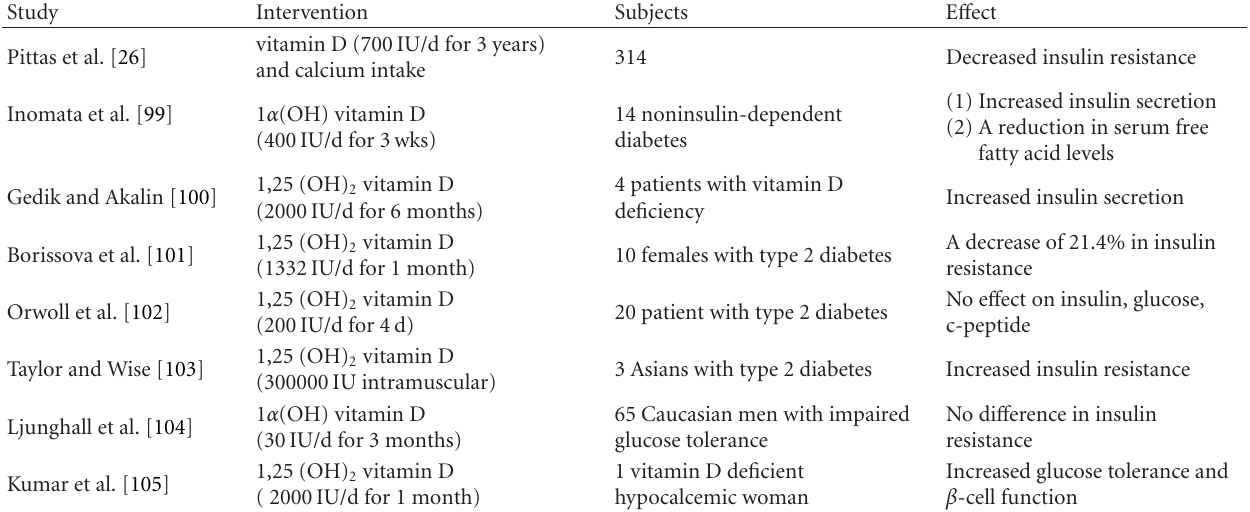
Table 2: E ff ects of vitamin D supplementation in insulin